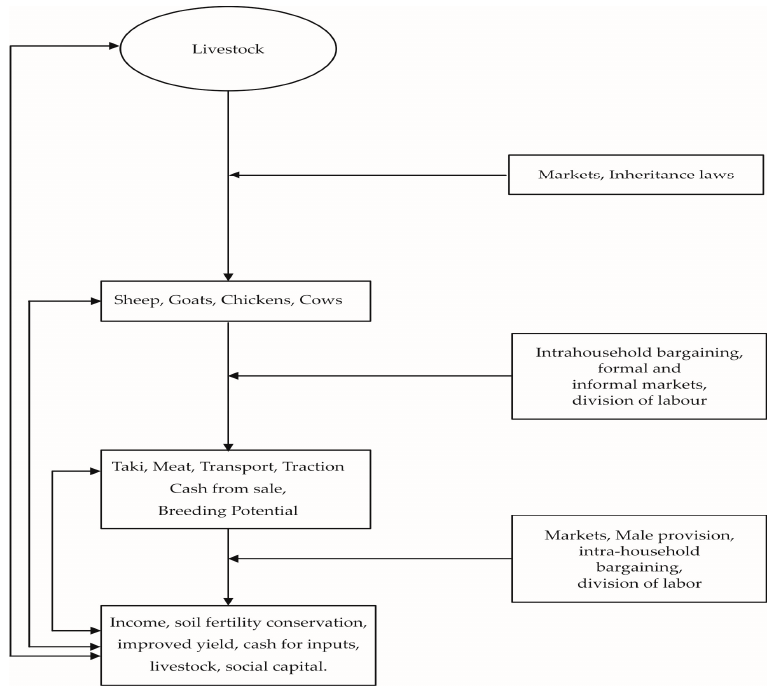
Figure 3. Environmental entitlement mapping: livestock (adapted from leach et al. [33]).